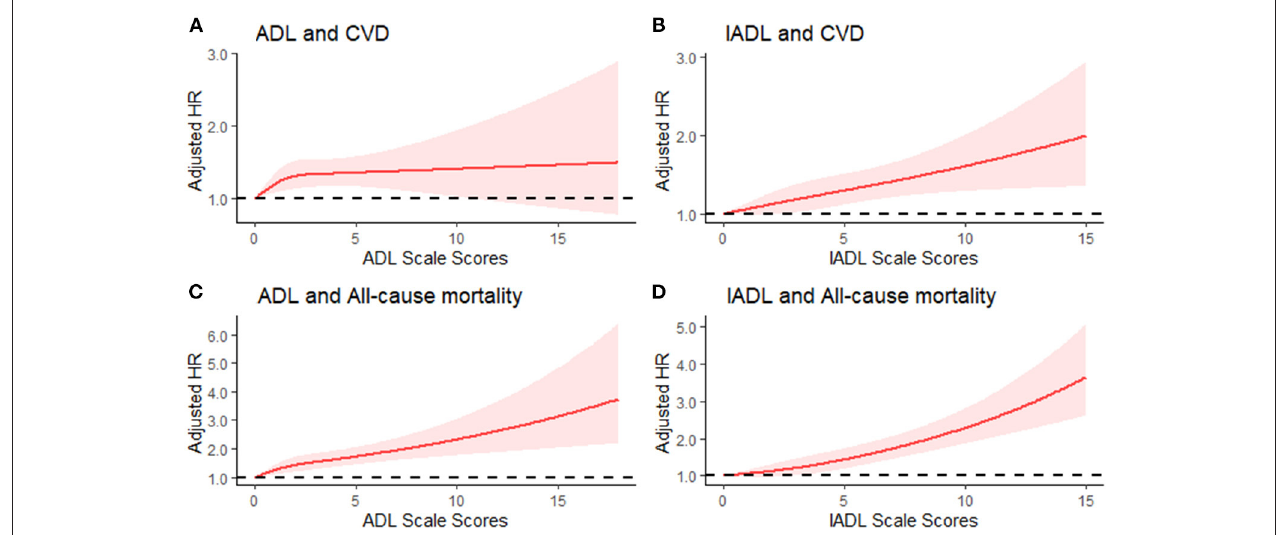
FIGURE 1 | Adjusted Hazard Ratio (HRs) of cardiovascular disease and all-cause mortality according to ADL and IADL scale score. (A) Adjusted HRs for association between ADL score and CVD; (B) Adjusted HRs for association between IADL score and CVD; (C) Adjusted HRs for association between ADL score and all-cause mortality; (D) Adjusted HRs for association between IADL score and all-cause